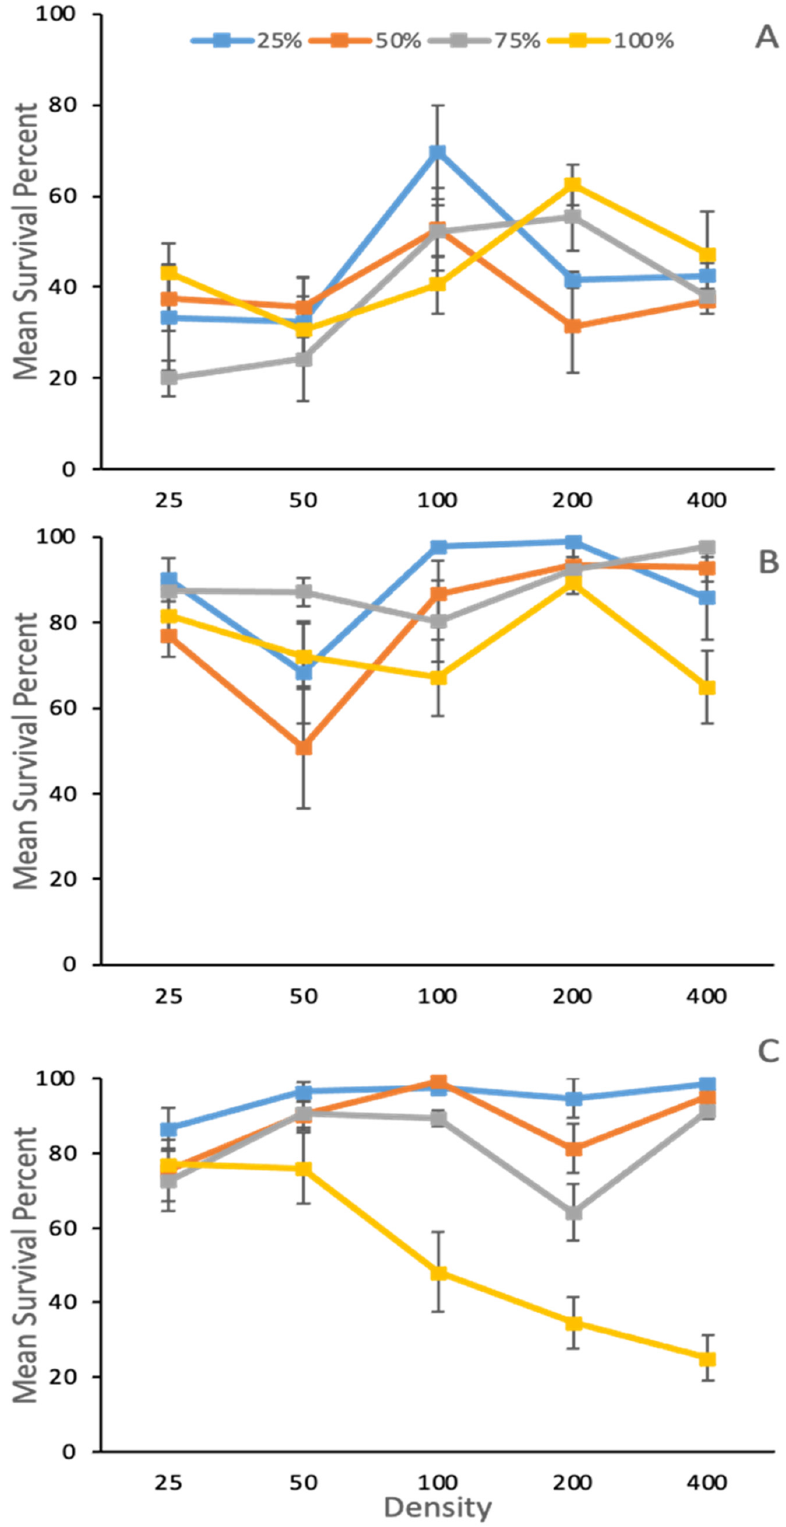
Figure 3. Mean ± SE percent survival to adult of Phormia regina Meigen (Diptera: Calliphoridae) reared within larval ratios of 100% P. regina , 75% P. regina to 25% Lucilia sericata Meigen (Diptera: Calliphoridae), equal 50:50 ratio, or 25% P. regina to 75% L. sericata at ( A ) 15 °C, ( B ) 25 °C, and ( C ) 35 °C across densities (larvae/jar). There was an interaction between density, species treatment, and temperature (F 3,584 = 6.02, p = 0.0005).